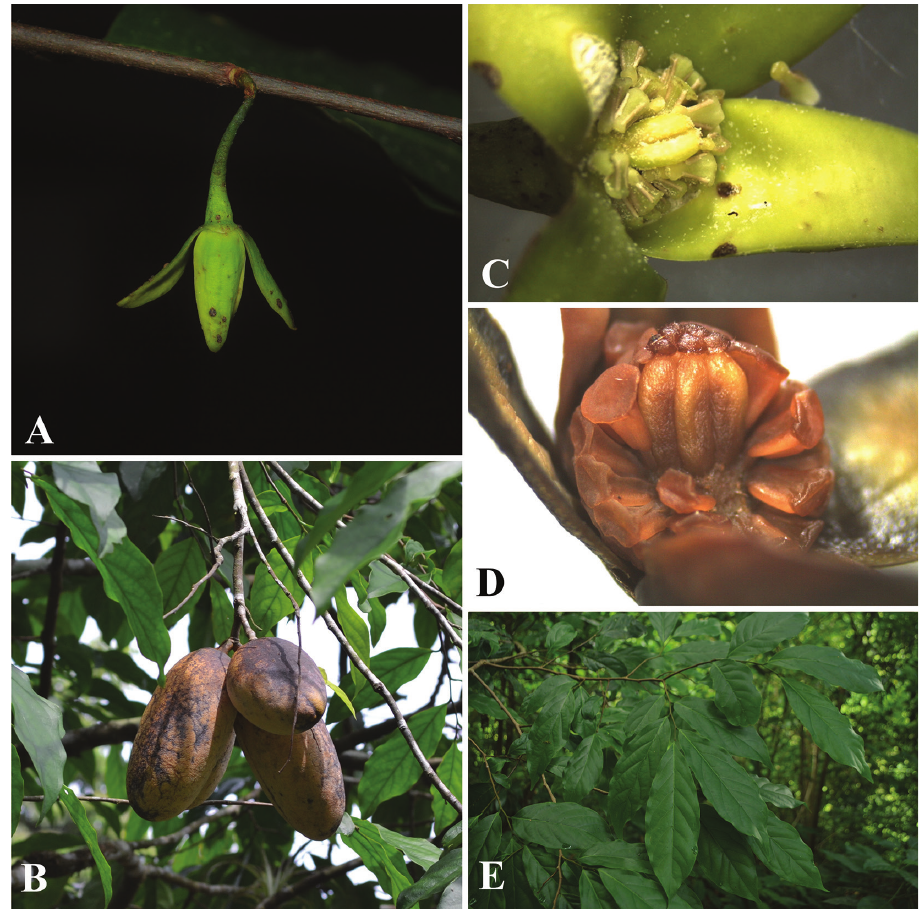
Figure 3. Tridimeris chiapensis Escobar-Castellanos & Ortiz-Rodr. A Dimerous flower B Large and fleshy fruits C Flower showing the pollen release and a triangular white patch at the base of the inner petals D Five carpels surrounded by numerous stamens E Leafy branches. Photographs by Marcos Escobar-Castellanos. km. 12 desvío a Montebello, 1081 m, 16°52'20.3"N, 93°19'32.5"W, 11 August 2016 (fl) Escobar-Castellanos M. A. 0689 (holotype HEM; isotypes: XAL,